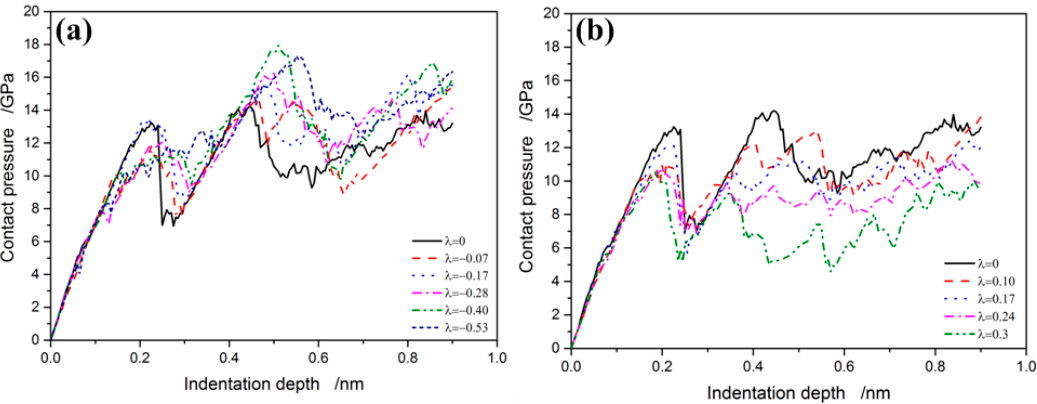
Figure 5. Mean contact pressure vs. indentation depth with different relative residual stress;